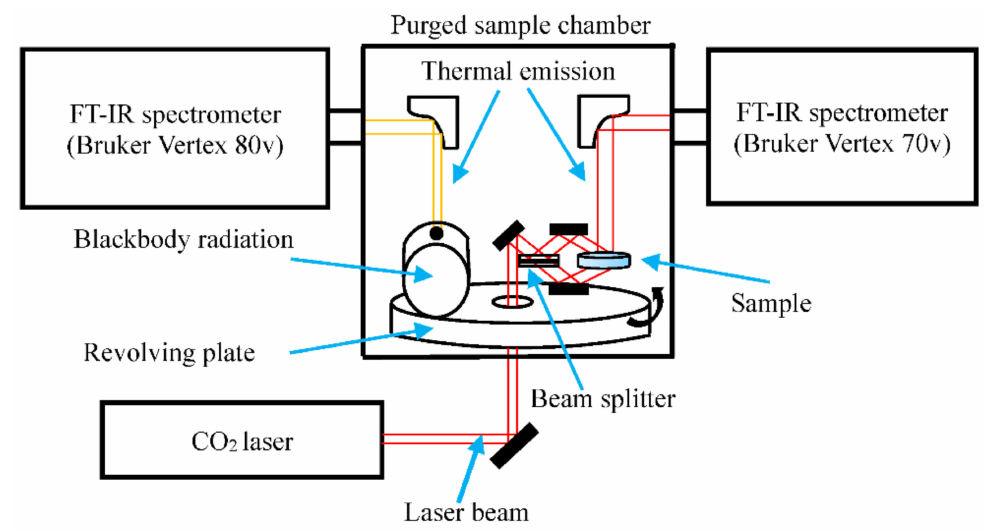
Figure 20. Improved measuring system for high-temperature emissivity